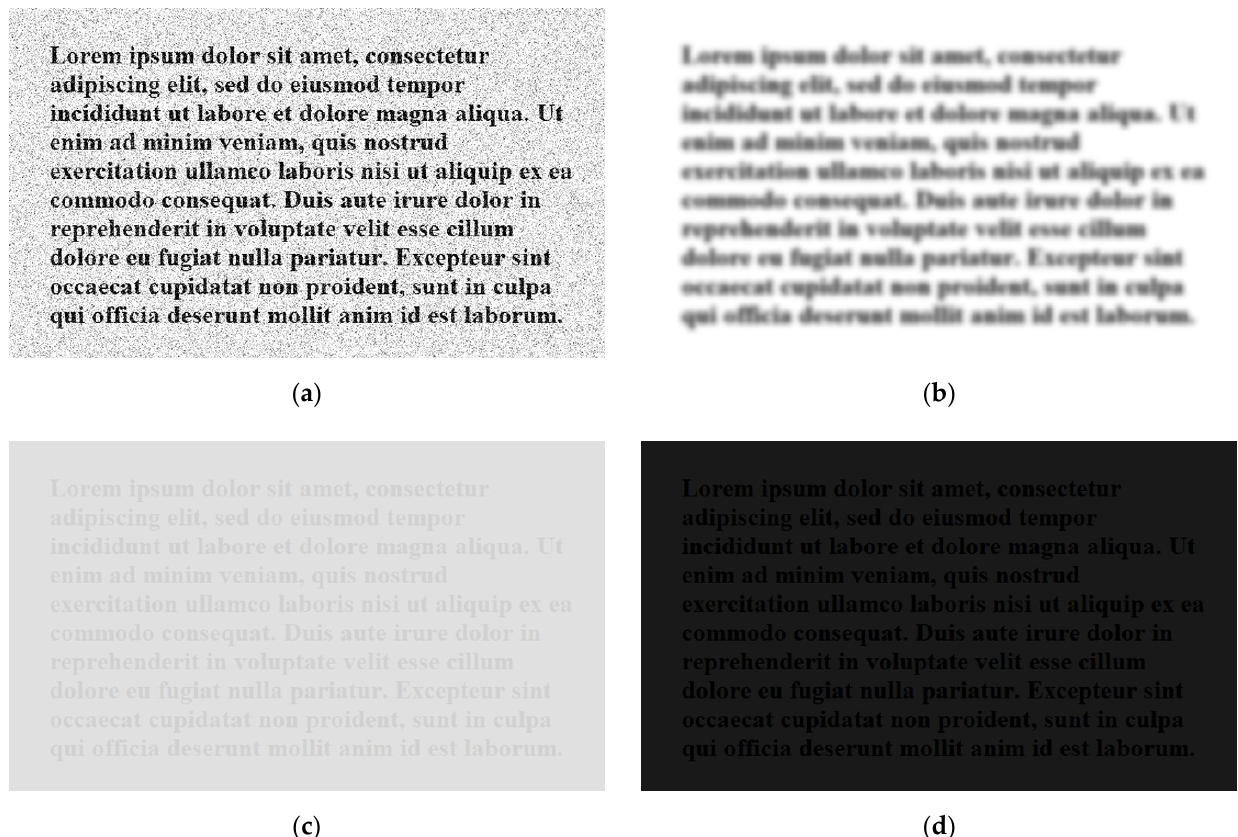
Figure 2. Degraded counterparts of the synthetic text image in Figure 1: ( a ) noisy (Gaussian noise added); ( b ) blurred (Gaussian blurring); ( c ) reduced contrast; ( d ) reduced brightness.